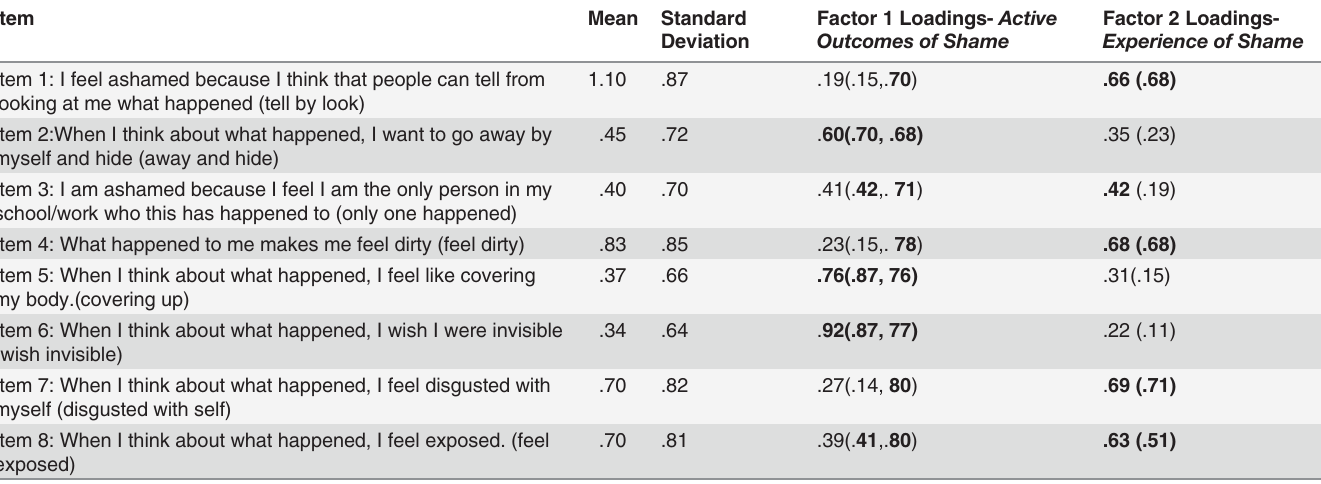
Table 2. The Shame Questionnaire Items and Exploratory Factor Analysis Varimax Rotated Factor Matrix of Shame Questionnaire. Item